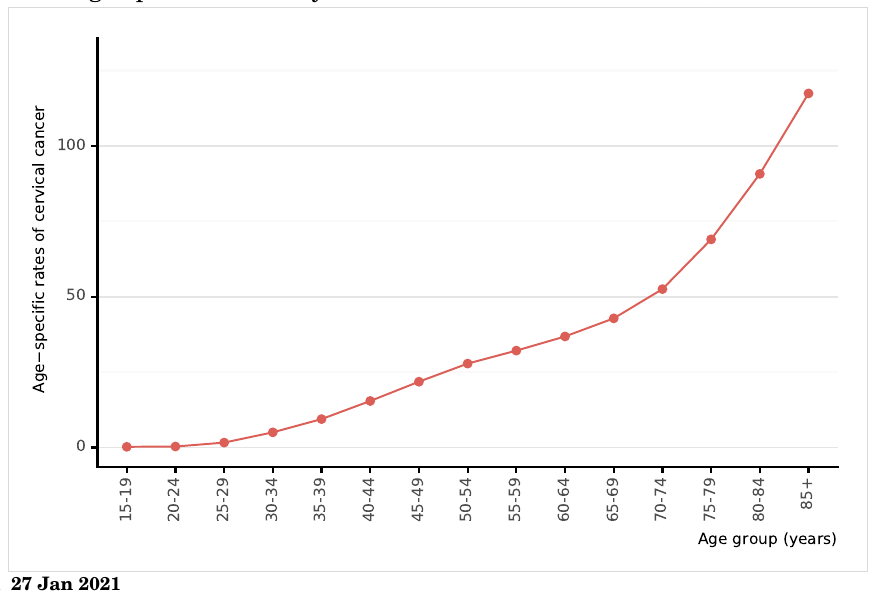
Figure 11: Age-specific mortality rates of cervical cancer in Peru (estimates for 2020)